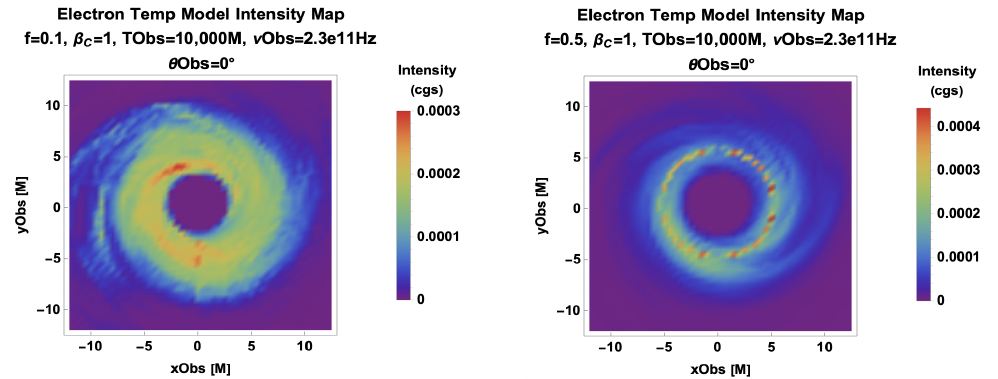
Figure 4. A parameter scan of the face-on Critical Beta Model with ( Left ) f = 0.1, ( Right ) f = 0.5, β c = 0.01 ( Top ), β c = 0.1 ( Middle ), and β c = 1 ( Bottom